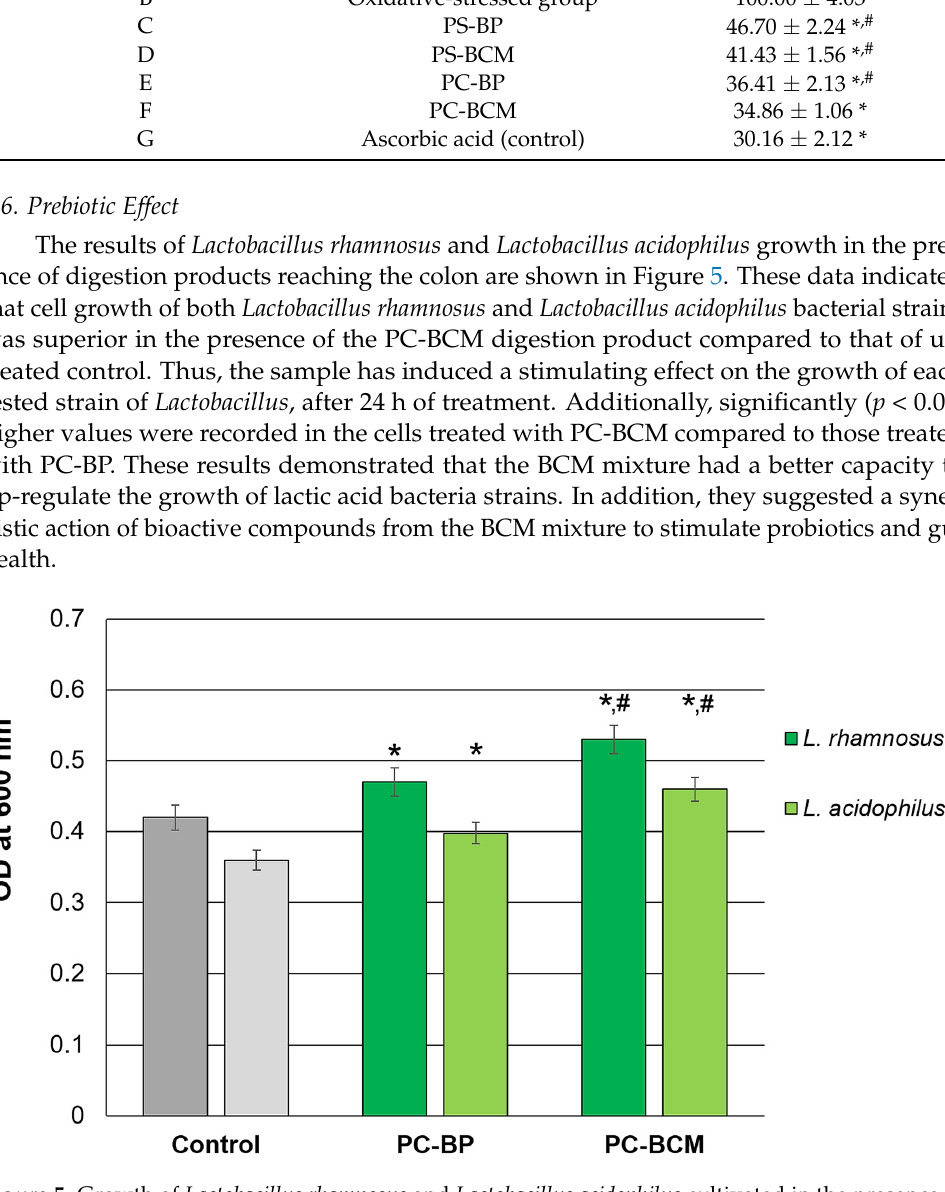
Figure 5. Growth of Lactobacillus rhamnosus and Lactobacillus acidophilus cultivated in the presence of 100 µg/mL of digestion products reaching the colon (PC) of blueberry pomace extract (BP) and BCM mixture, after 24 h of treatment. The results are expressed as mean ± SD ( n = 3). * p < 0.05, compared to untreated control; # p < 0.05, compared to PC-BP.